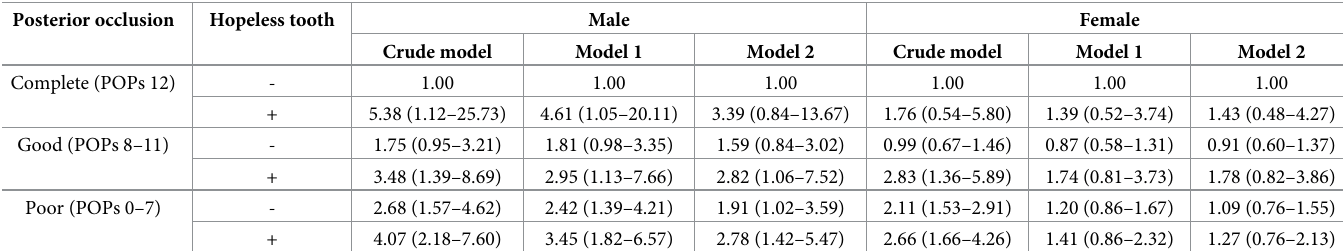
(OR = 1.75, 95% CI = 0.95–3.21). In the absence of hopeless teeth, the association disappeared Table 2. Odds ratios (ORs) and 95% confidence intervals (CIs) for low handgrip strength according to POPs and the presence of hopeless tooth. Posterior